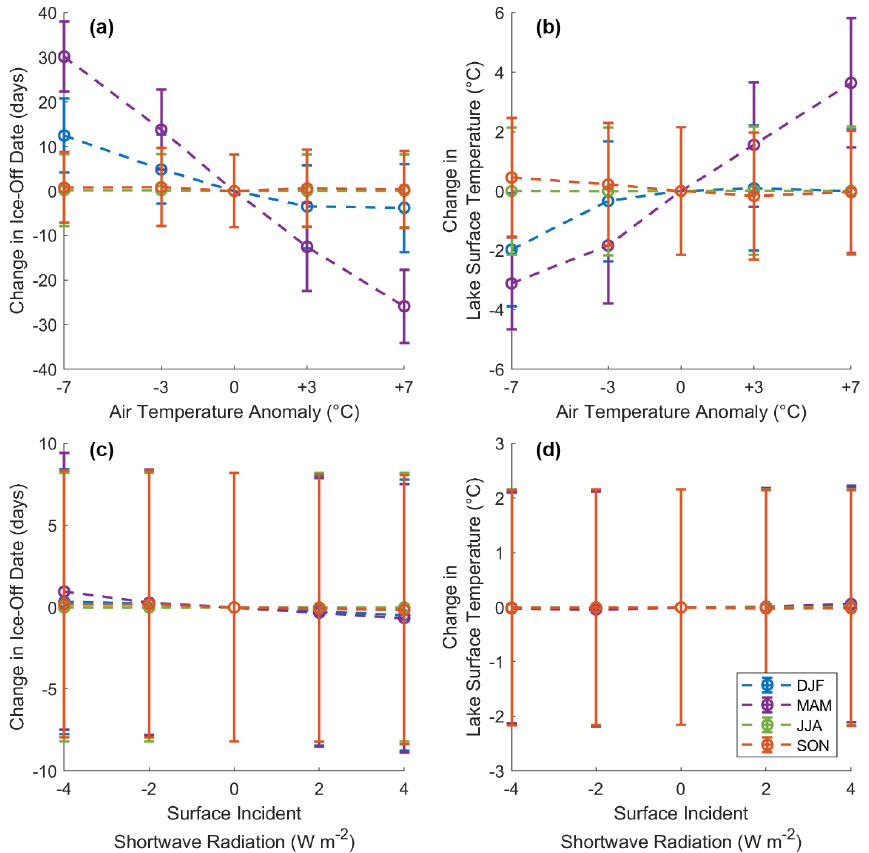
Figure 5. Lake model sensitivity tests showing the impacts of air temperature perturbations during different seasons on (a) ice-out dates and (b) lake water temperatures on 1 May. Similarly, the effects of shortwave radiation on (c) ice-out dates and (d) lake water temperatures are shown. Changes in ice-out dates and lake surface temperatures were calculated relative to the control simulation. Seasonal changes are shown for winter (DJF, blue), spring (MAM, purple), summer (JJA, green), and fall (SON,